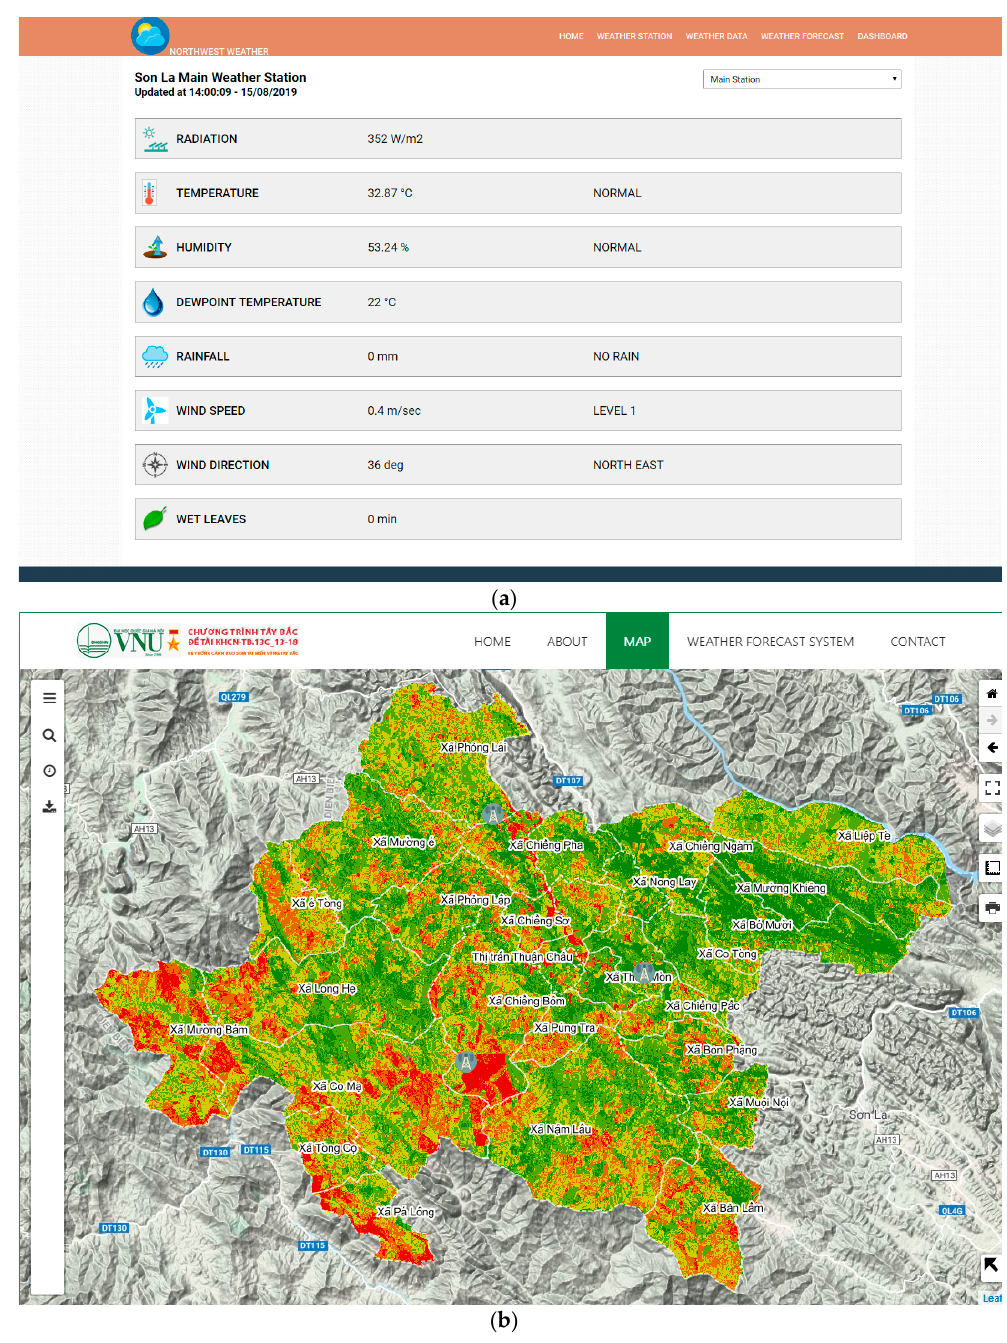
Figure 11. The user interface of the software ( a ) and the forest fire warning website ( b ).